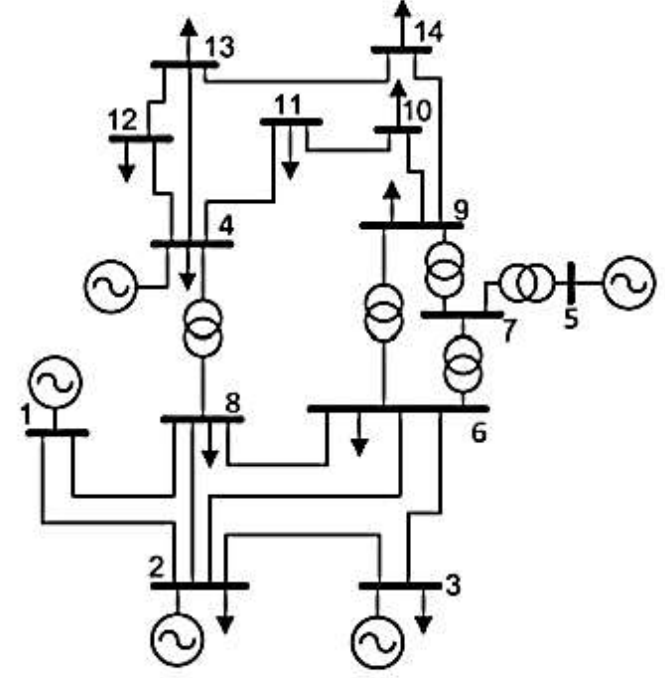
Figure 4. Test Figure 4. Test system. Table 2. Test system line data (in pu).